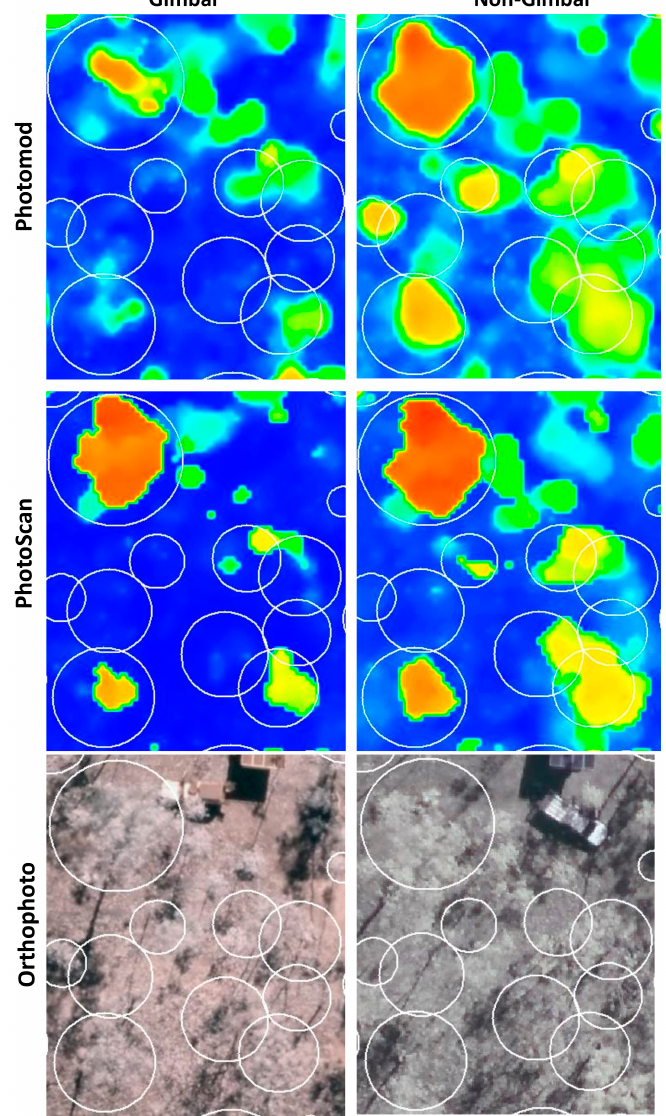
Figure 8. Study area subsets (28 × 24 m) demonstrating the better results of the non-gimbal over the gimbal-derived raster CHMs. CHM resolution is 40-cm GSD. White circles represent the crowns of reference trees (height > 10 m).